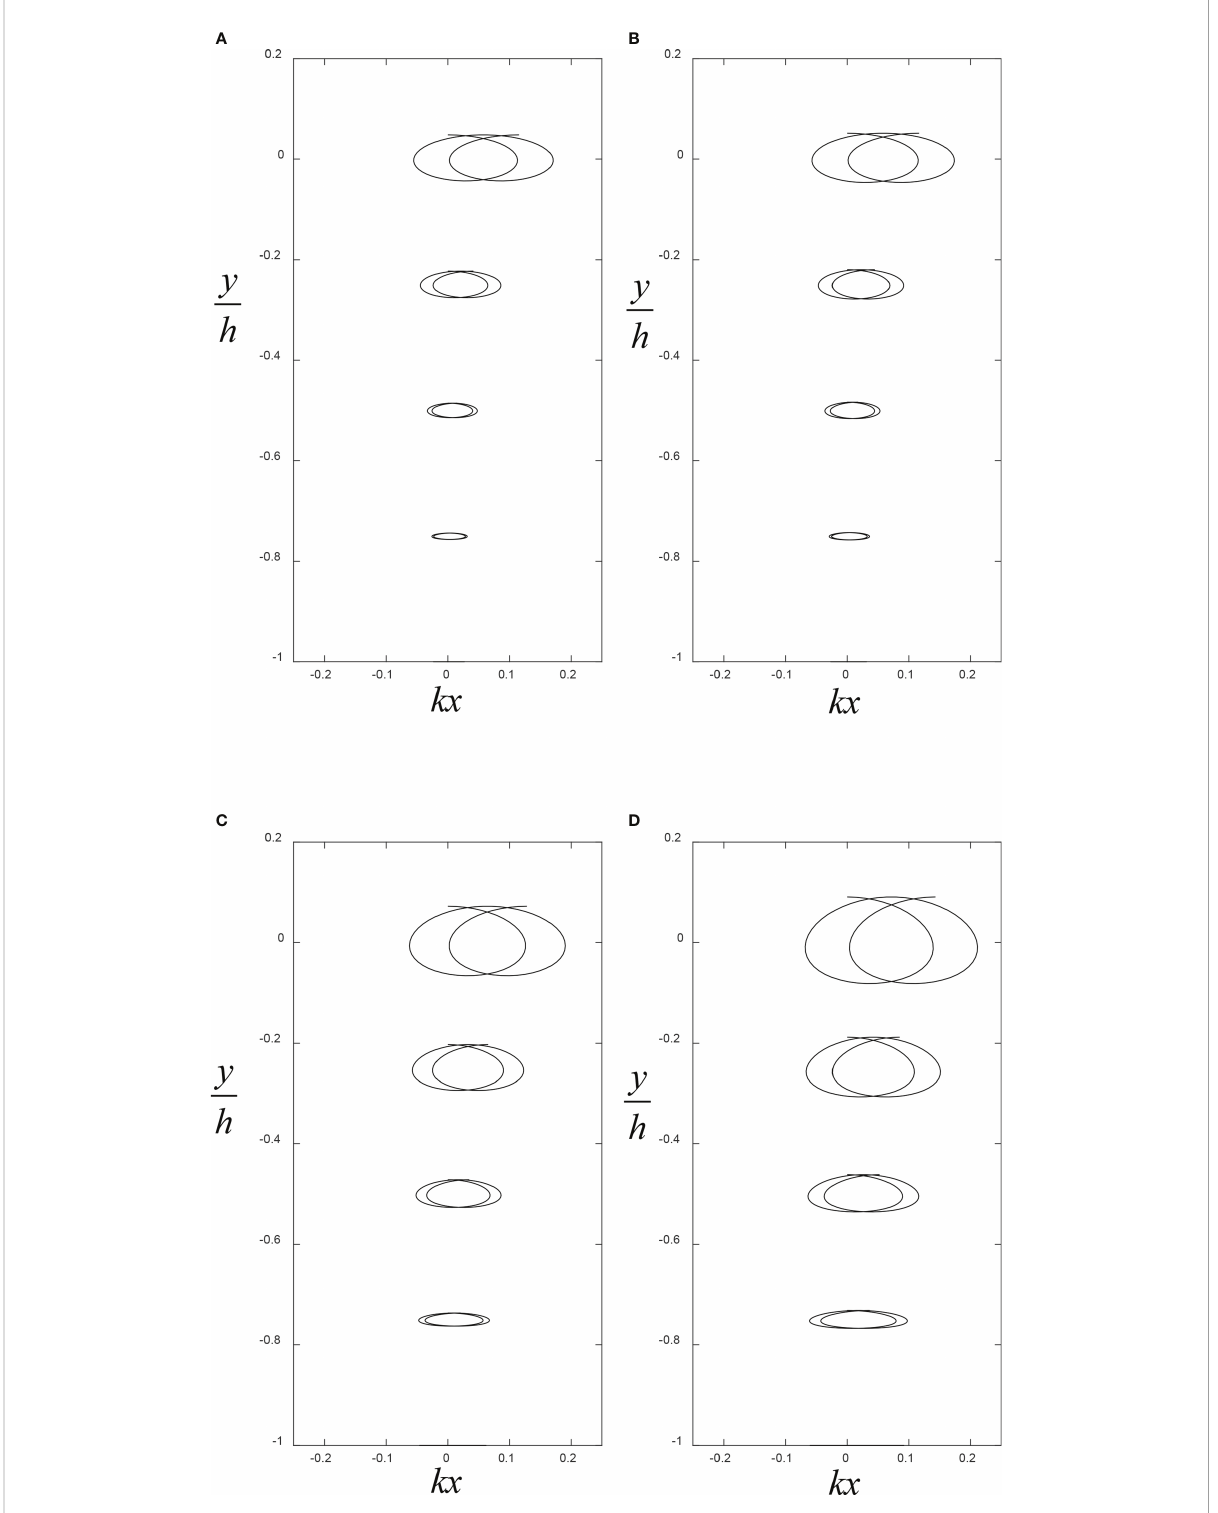
FIGURE 3 (A – D) The variation of third-order water particle trajectories at different vertical labels b for water depth h = 50 m under various thicknesses of the ice sheet d = 0, 0.5, 1, 3